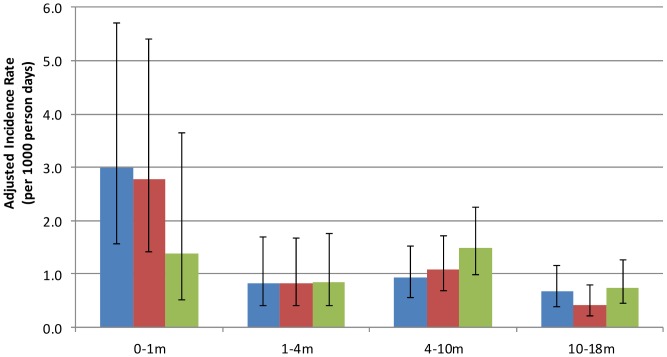
Risk for hospitalization.Gender-adjusted incidence rates of hospitalization (±95% confidence intervals) during the 1st month, 1–<4 months (PCV immunization ongoing), 4–<10 months (PCV immunization completed), and 10–18 months (post-PPV) of life for the neonatal PCV (green bars), infant PCV (red bars) and control group (blue bars).